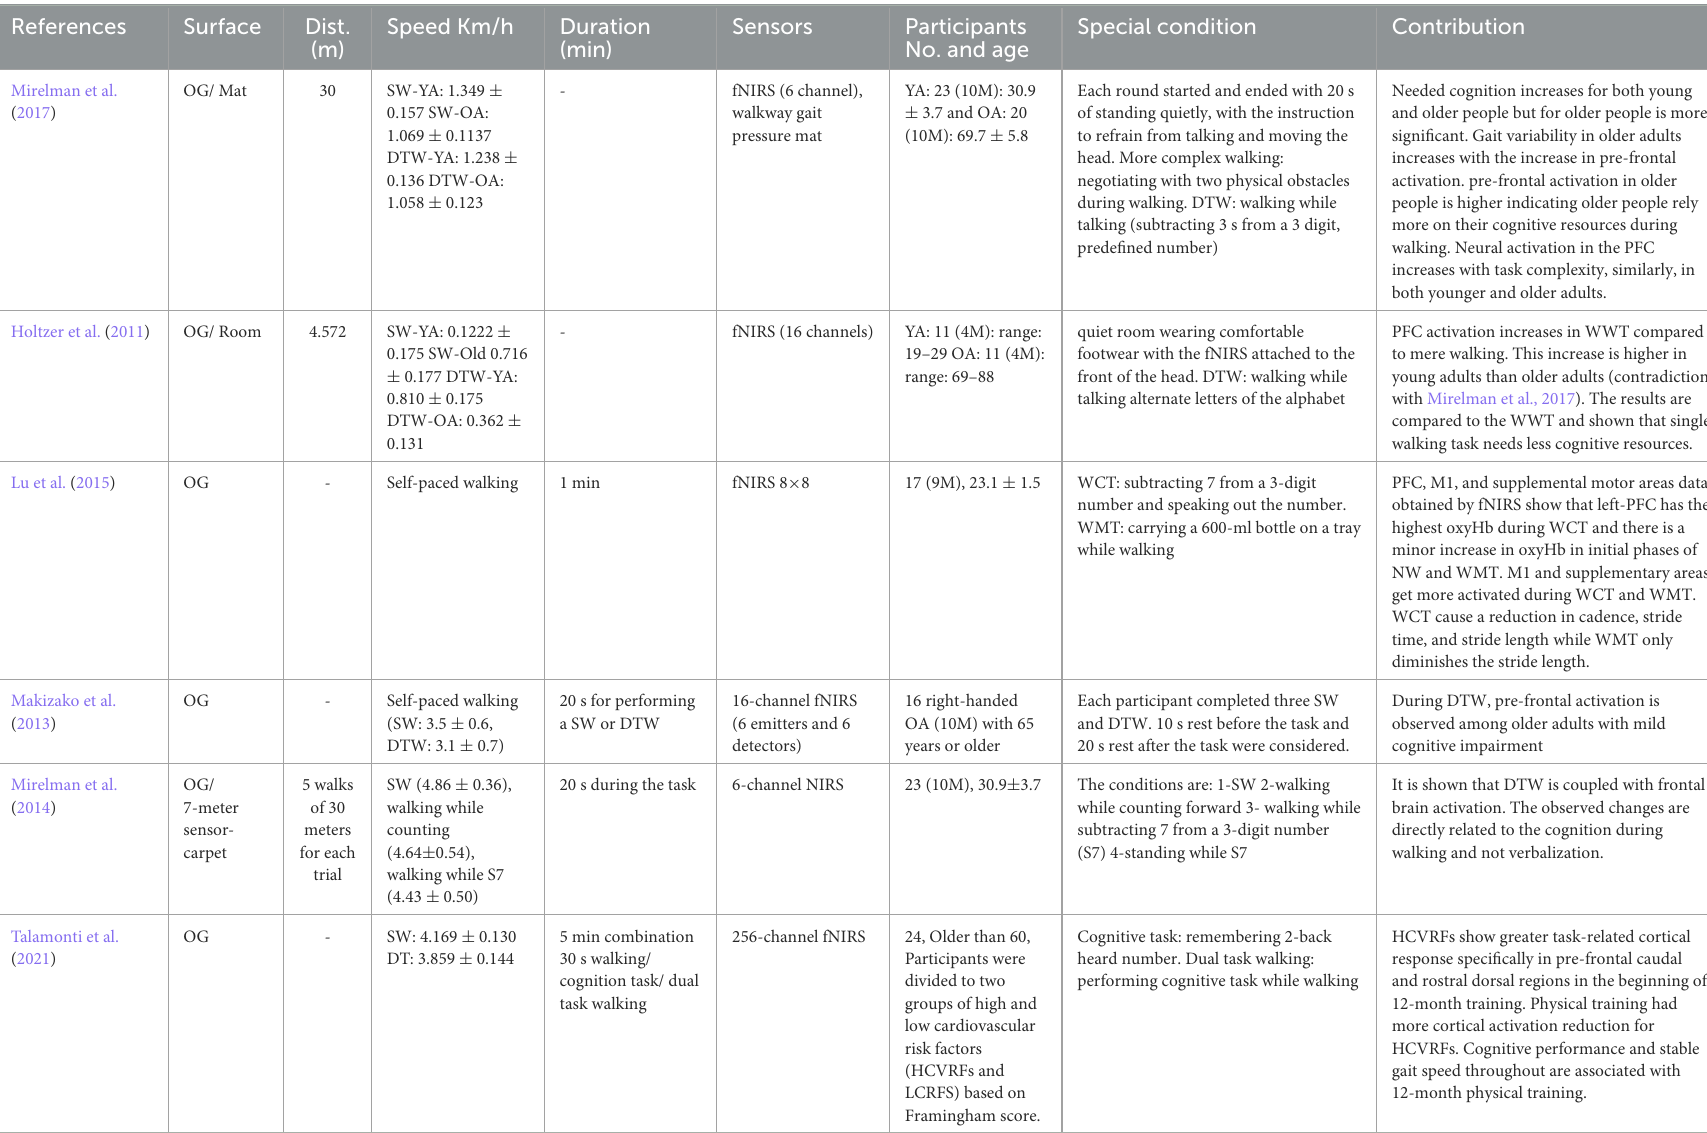
TABLE 7 Brain-body imaging in dual-task